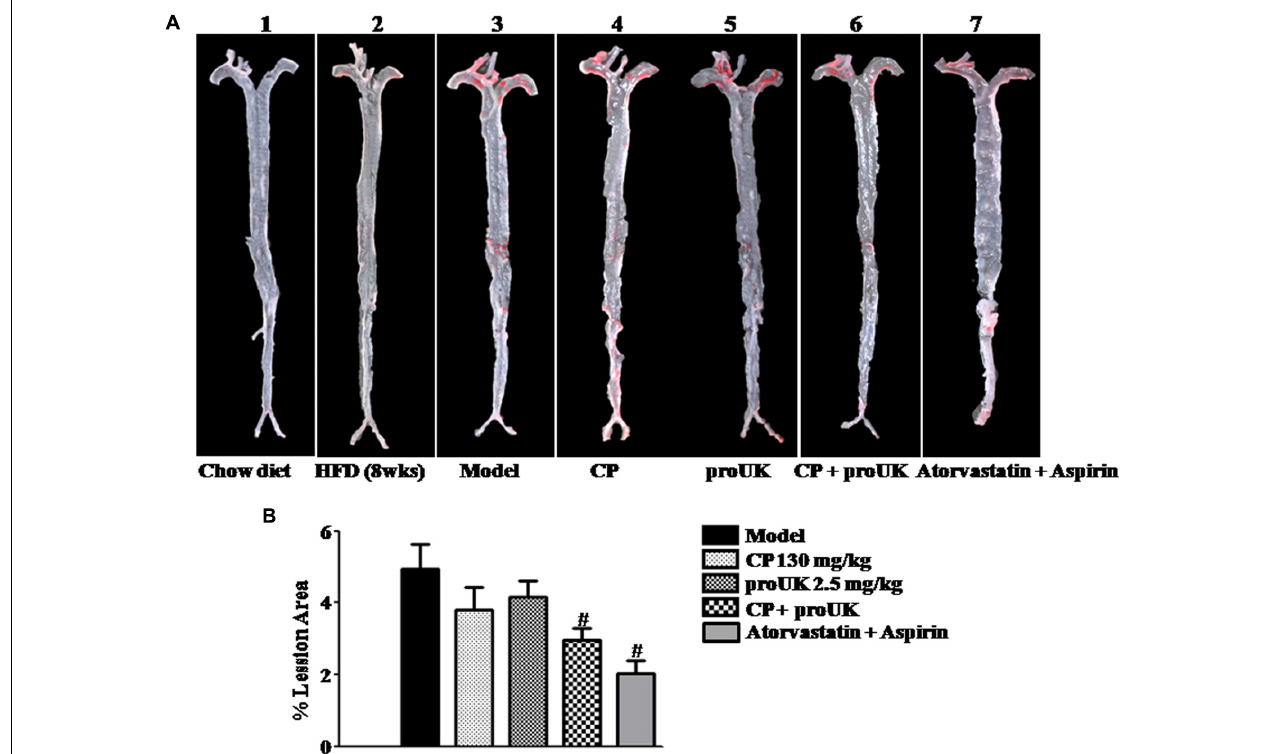
FIGURE 1 | CP plus proUK inhibits the development of atherosclerosis in LDLR − / − mice. High fat diet-fed LDLR − / − mice were randomly divided into 4 groups and received CP orally or/and proUK injection. (A) Representative images of en face Oil Red O staining of the full length of aorta of LDLR − / − mice from Chow diet group (A-1) , n = 3. High fat diet-fed mice for 8 weeks group (A-2) , n = 2. Model group (A-3) , n = 12. CP + HFD group (A-4) , n = 12. proUK + HFD group (A-5) , n = 12. CP plus proUK group (A-6) , n = 12. Atorvastatin + Aspirin group (A-7) , n = 8. (B) Percent lesion area of aorta in different groups. Data are presented as the percentages of total en face aortic area. n = 10. # P < 0.05 vs. Model mice.